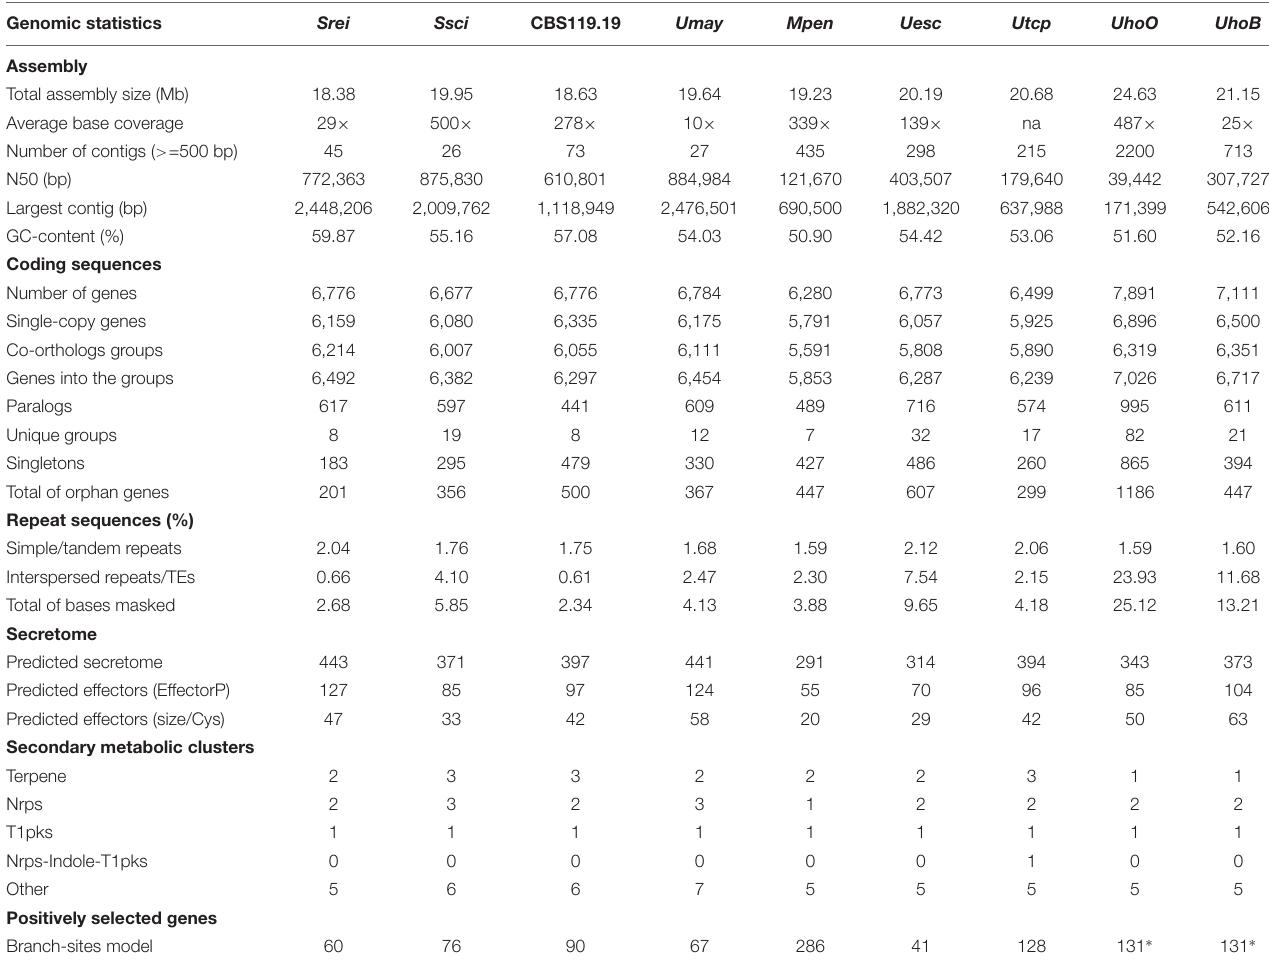
TABLE 2 | Genomic statistics of smut